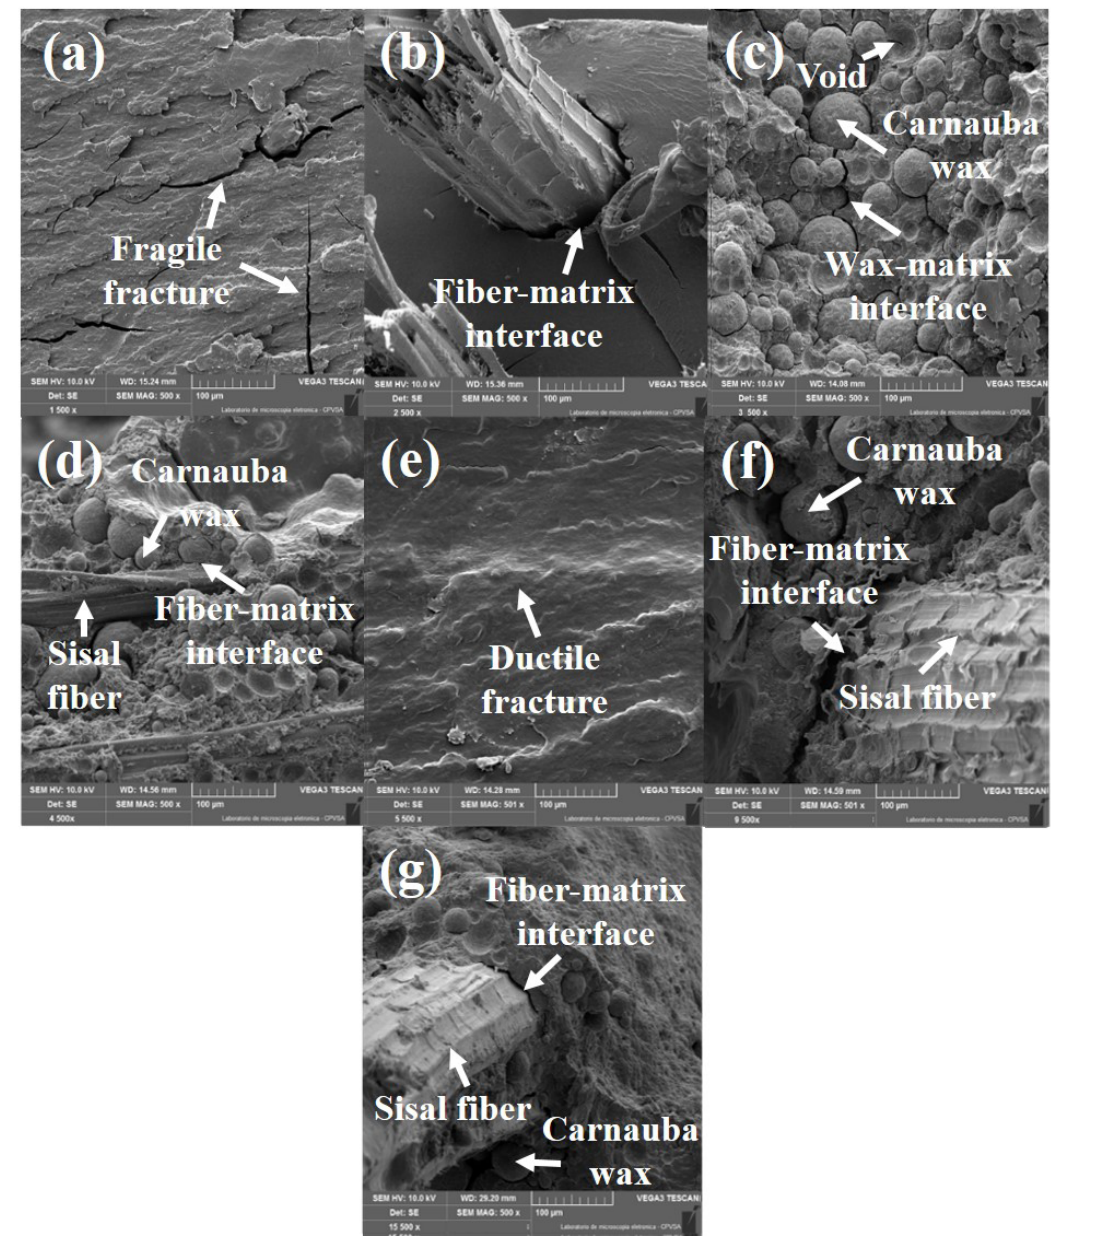
Figure 1. Scanning electron micrographs of the fractured surfaces for the biocomposites (a) I, (b) II, (c) III, (d) IV, (e) V, (f) IX and (g) XV.